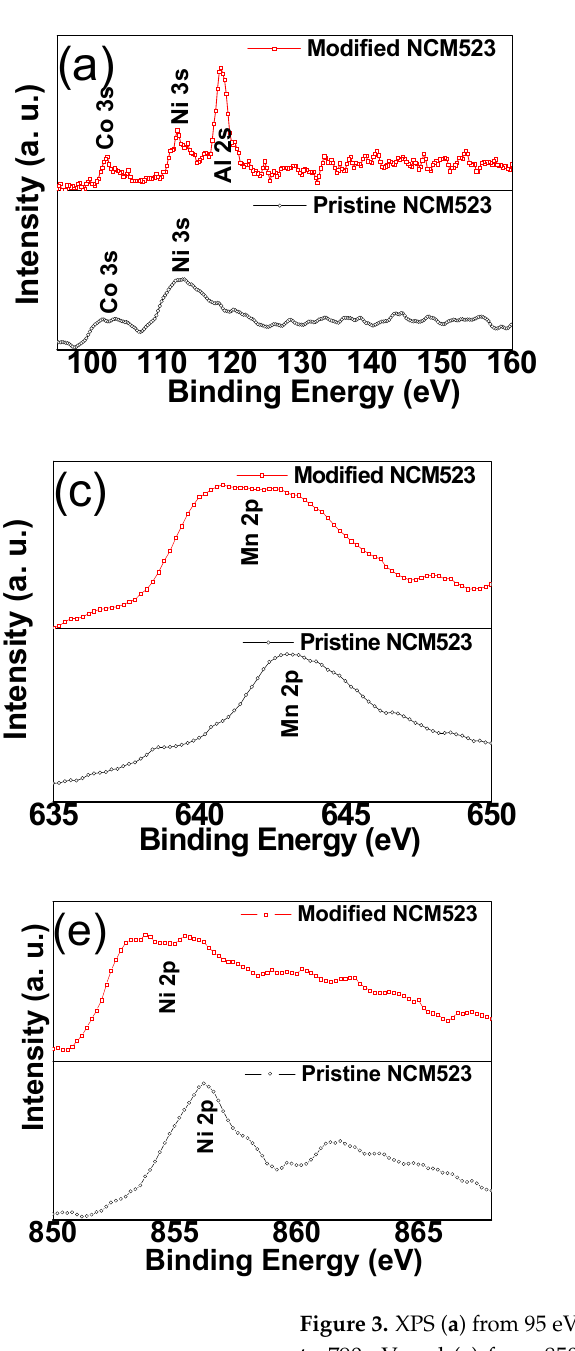
Figure 3. XPS ( a ) from 95 eV to160 eV, ( b ) from 520 eV to 540 eV, ( c ) from 635 eV to 650 eV, ( d ) 770 eV to 790 eV and ( e ) from 850 eV to 870 eV of NCM523 with/without Al 2 O 3 surface coating doping, suggesting that Al may not only exist as Al 2 O 3 but that it also gets into the lattice structure of NCM523.